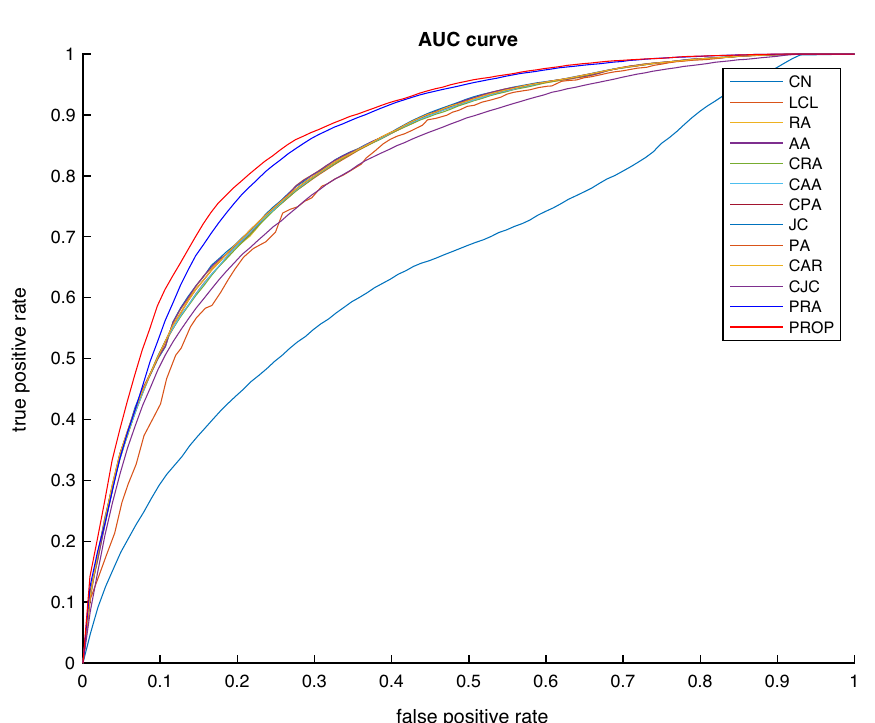
Figure 3. Comparison of the receiver operating characteristic curves of different methods when applied to the MM1